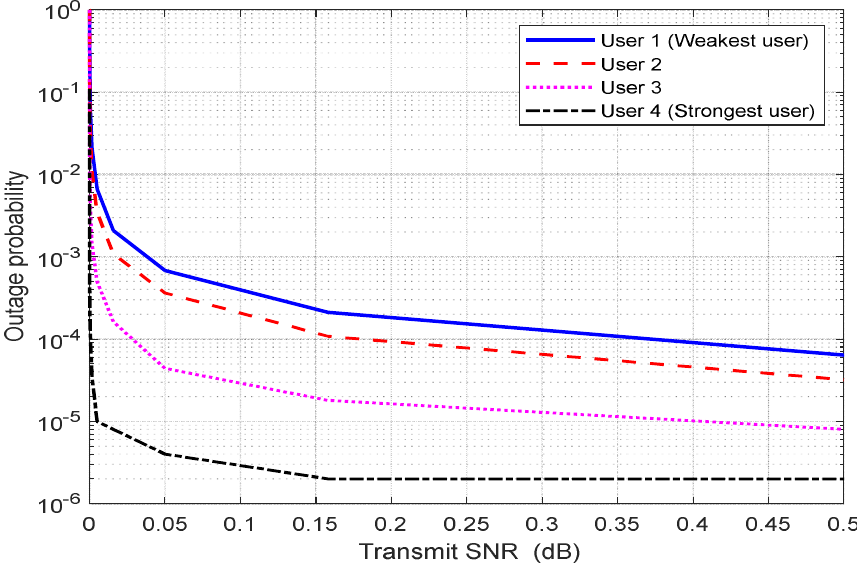
Figure 15. OP vs. SNR for four users with varying distances and BW 80 MHz for UL NOMA.